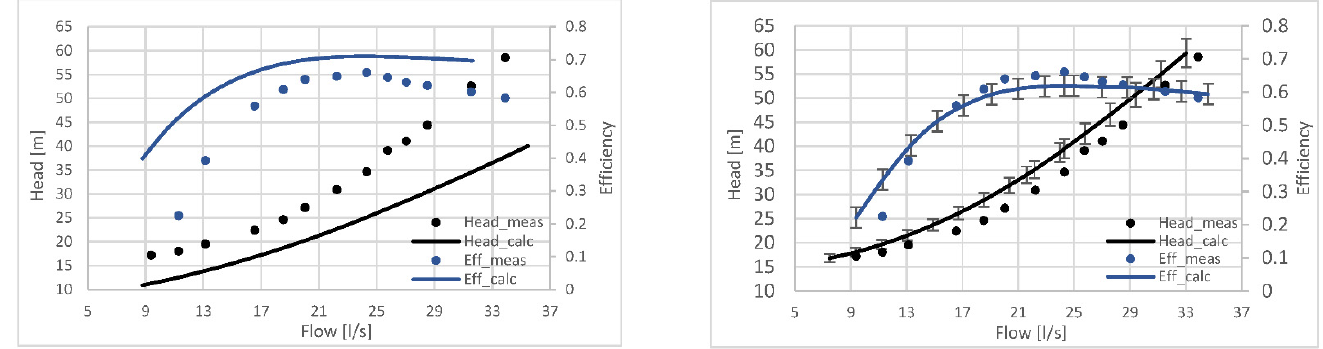
Figure 15. ( A ) Head and efficiency for the PAT 65-250 (nst = 15.83) in turbine operation. ( B ) Head and efficiency for the PAT 65-250 with z = 6 in b = 0.038, b5 = 0.054 m, and cl = 3.5 × 10 − 4 m.